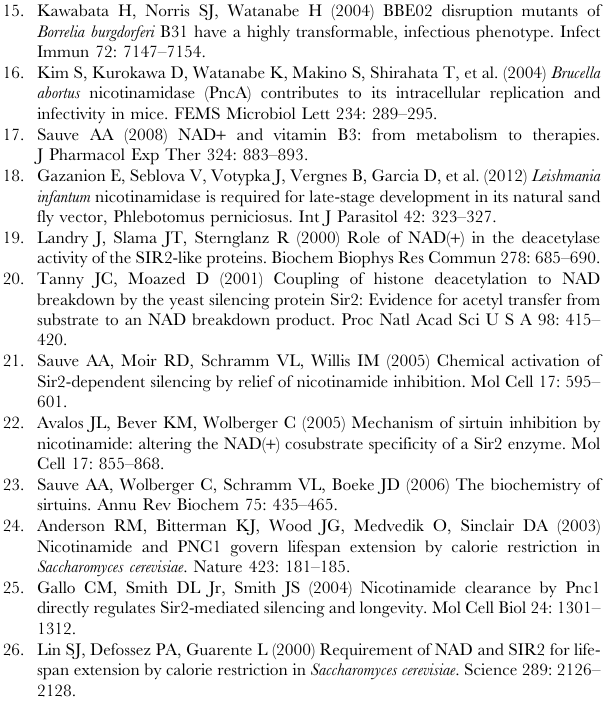
Figure S4 Modelled structure of OiNIC. Zn 2 + atom is shown as a sphere and nicotinic acid as sticks. Figure S5 Phylogenetic distribution of nicotinamidases from phylum Firmicutes. The phylogenetic tree was obtained using MEGA 5.0 [53]. Figure S6 Phylogenetic distribution 16S rRNA of the Firmicutes microorganisms. The species were the same as those used in Fig. S5. The phylogenetic tree was obtained using MEGA 5.0 [53]